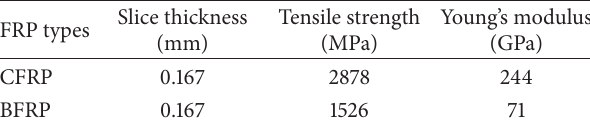
Table 2: Material parameters of